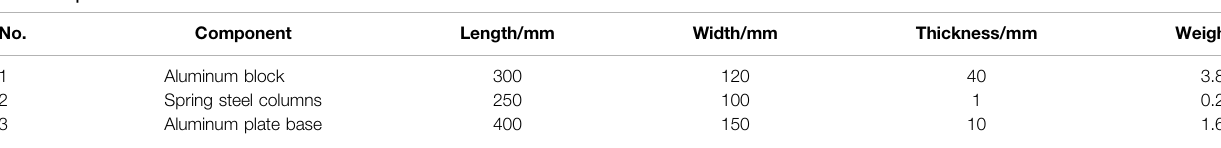
TABLE 2 | Parameters of Portal